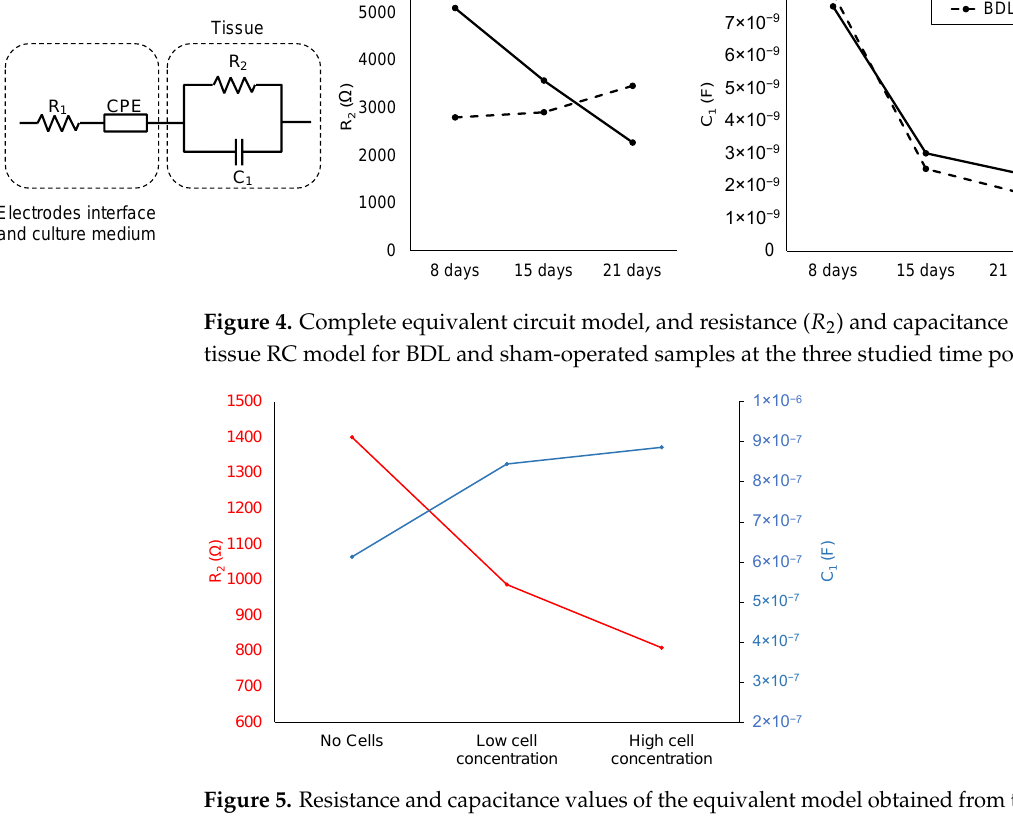
Figure 5. Resistance and capacitance values of the equivalent model obtained from the 3D cell culture measurements. Low and high cell concentrations correspond to 1 × 10 5 cells/ml and 5 × 10 5 cells/mL Hep-3B, respectively. Cells were cultured in a collagen sandwich gel at a concentration of 2